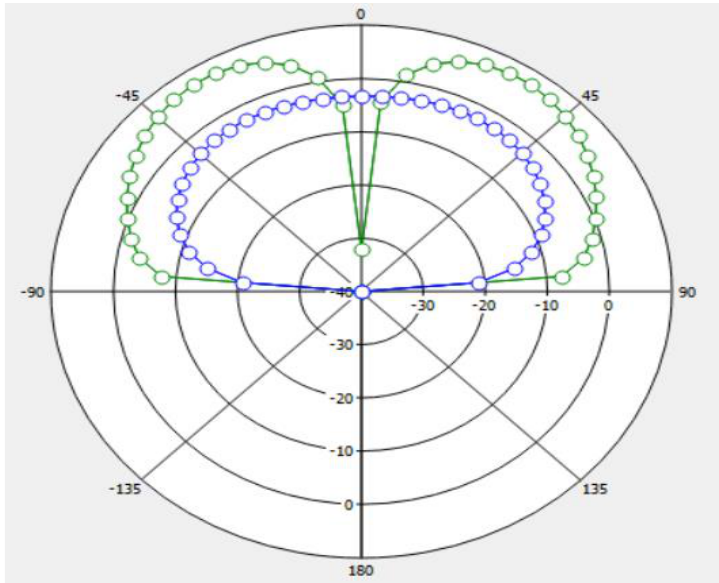
Figure 3. Far field radiation (Eφ and Eθ) for bow-tie antenna. Green represents Eθ, blue represents Eφ